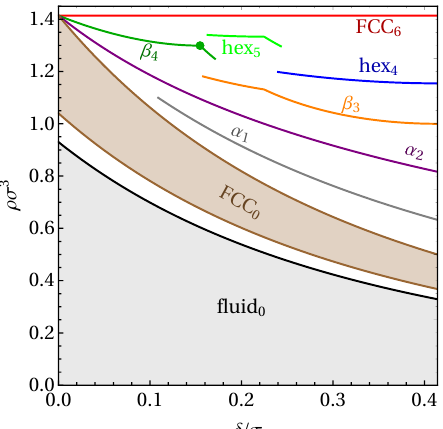
Figure 4. Phase diagram of the hard core square shoulder model in the zero-temperature limit, as a function of interaction range δ and number density ρ . The white areas indicate coexistence regions. All tie lines between coexisting state points are vertical. The green point marks the value of δ / σ where the ground-state β 4 corresponds to a body-centered cubic (BCC) lattice.